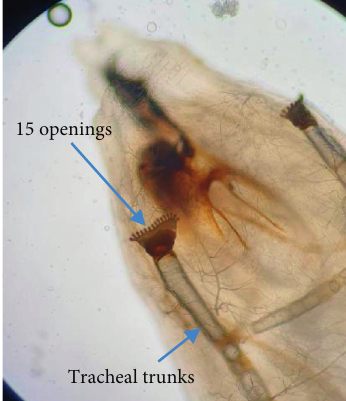
Figure 5: Prothoracic spiracles.